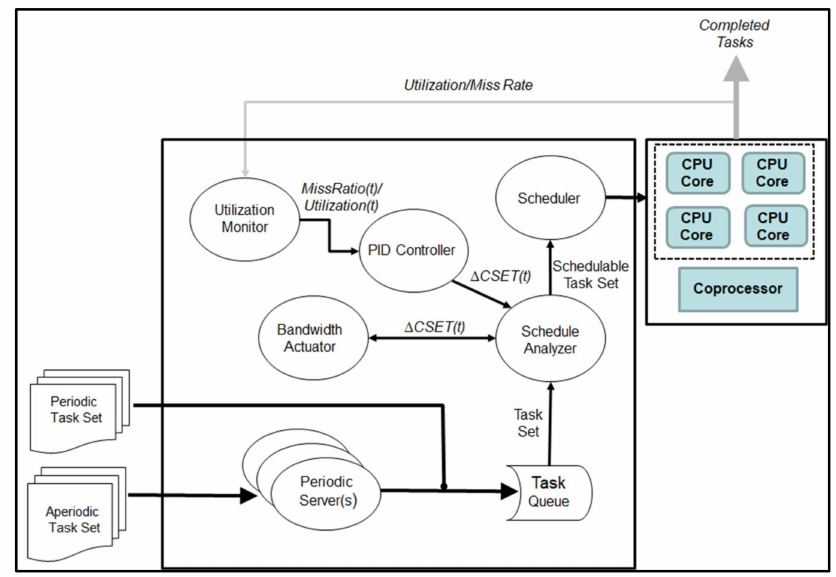
Figure 3. Feedback control real-time scheduler